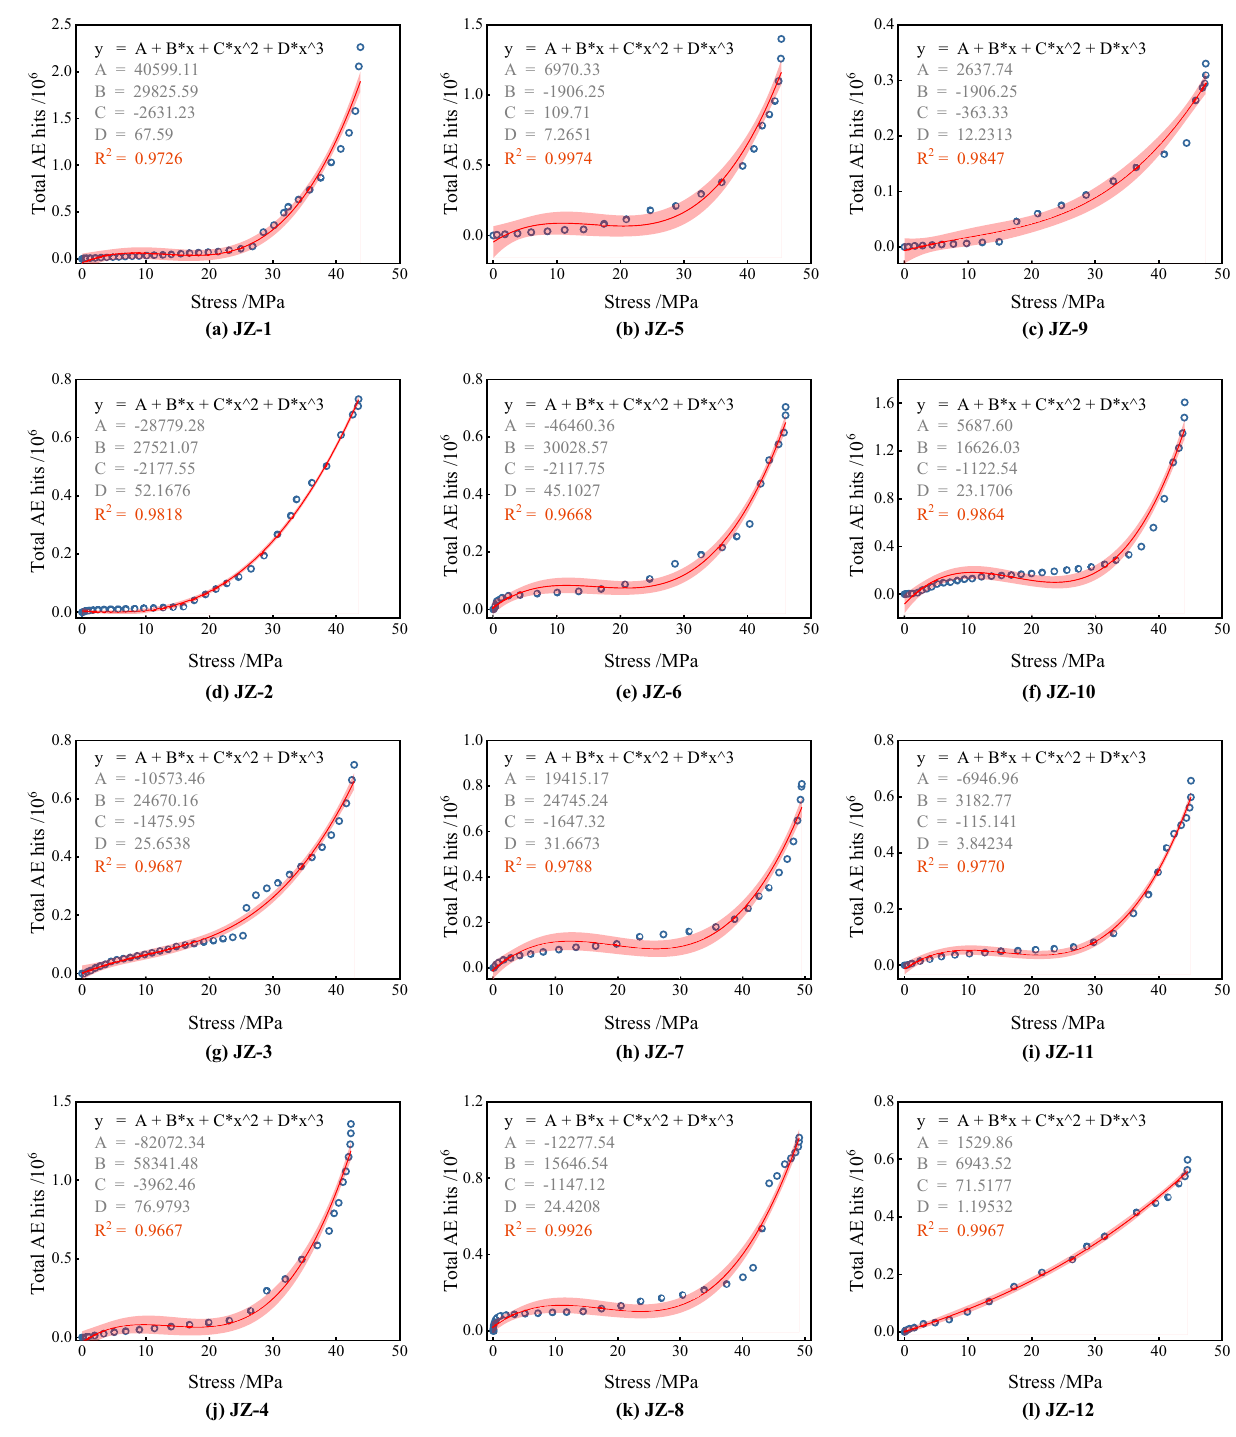
Figure 13. The fitting curve of total AE hits and stress in each